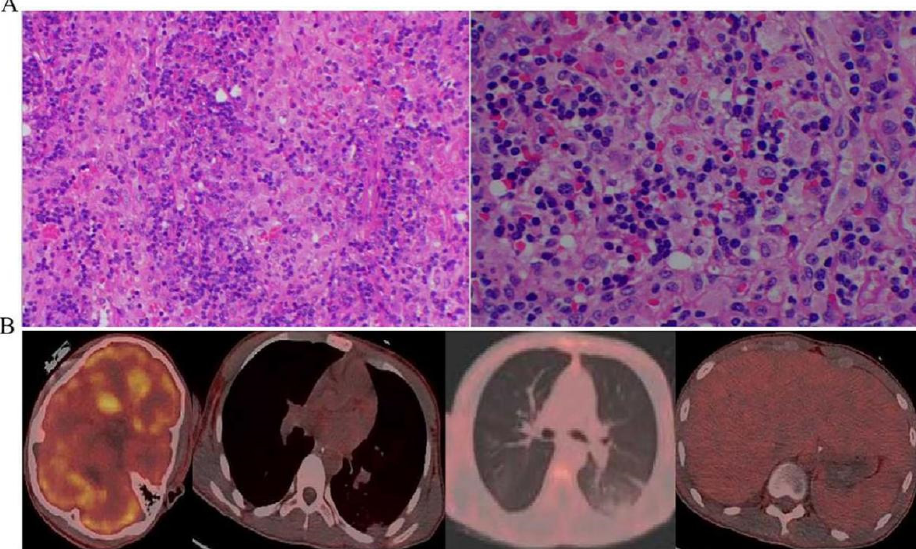
Figure 3. No signs of malignancy were seen in this patient. ( A ) Microscopically, the lymph node structure was destroyed, and no obvious lymphoid follicle structure was found. The interfollicular area and lymphatic sinus were enlarged. Significant histiocyte infiltration with phagocytosis of erythrocytes and lymphocytes by histiocytes. ( B ) PET-CT showed no signs of malignancy with abnormally increased